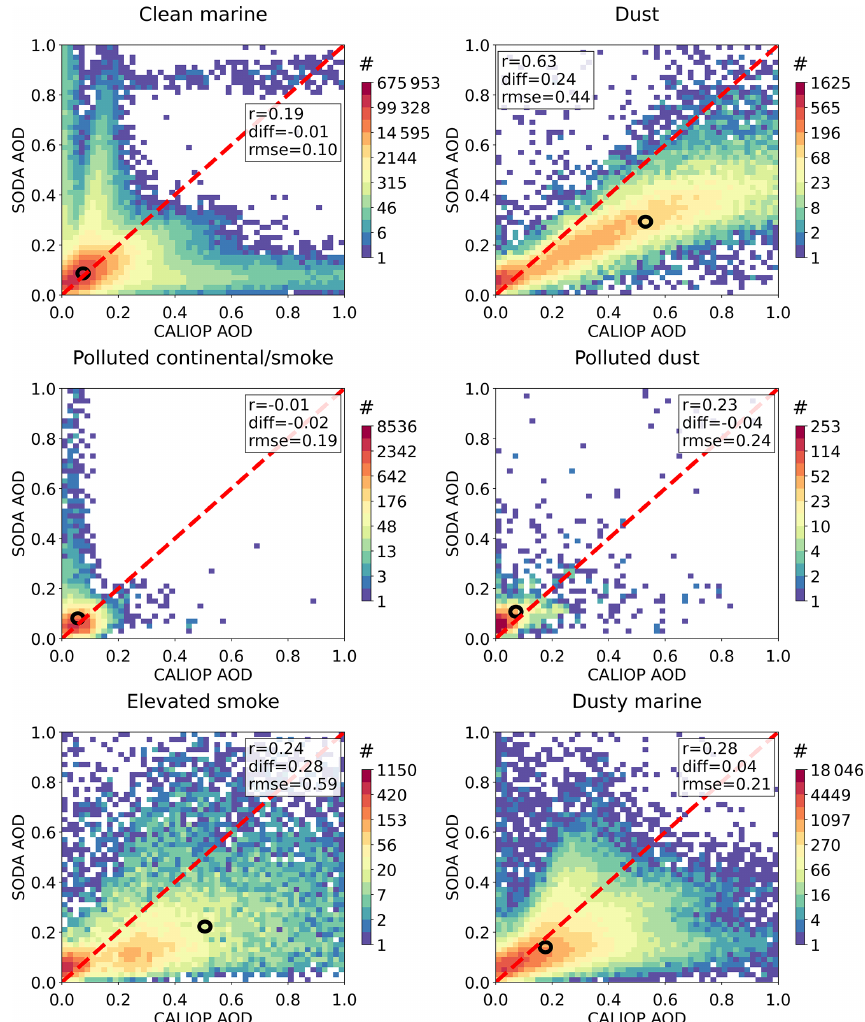
Figure 6. Bivariate histograms between SODA and CALIPSO AOD but for nighttime retrievals. Black circles represent the mean SODA and CALIPSO AOD.